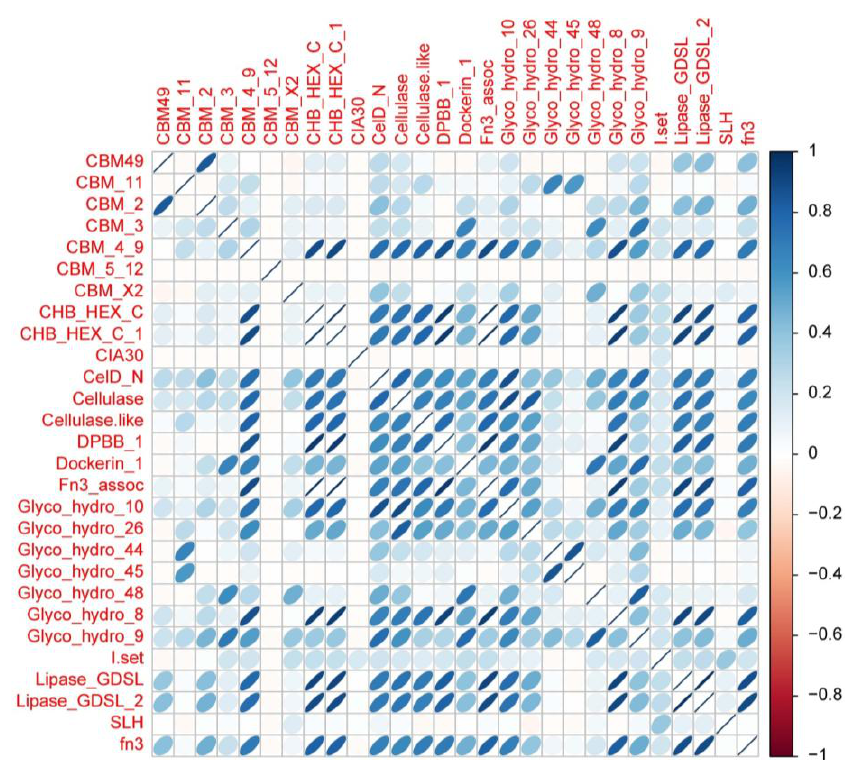
Figure 2. Correlation plot between each cellulase activity protein domain in goat